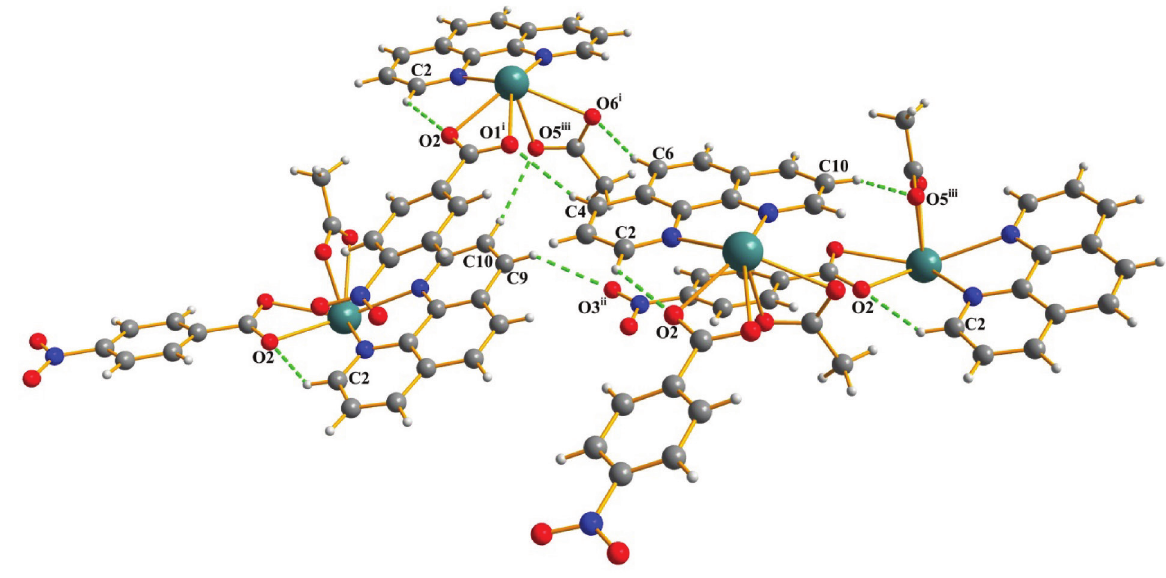
Figure 2: Hydrogen bonds as green dashed lines. Symmetry code: (i) -1+ x , y , z ; (ii) -1+ x , 1+ y , z ; (iii) 3/2- x , 1/2+ y , 1/2- z .